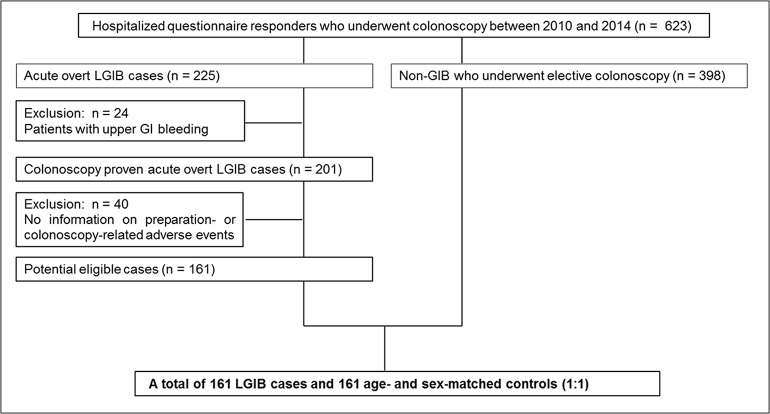
Study flow chart.